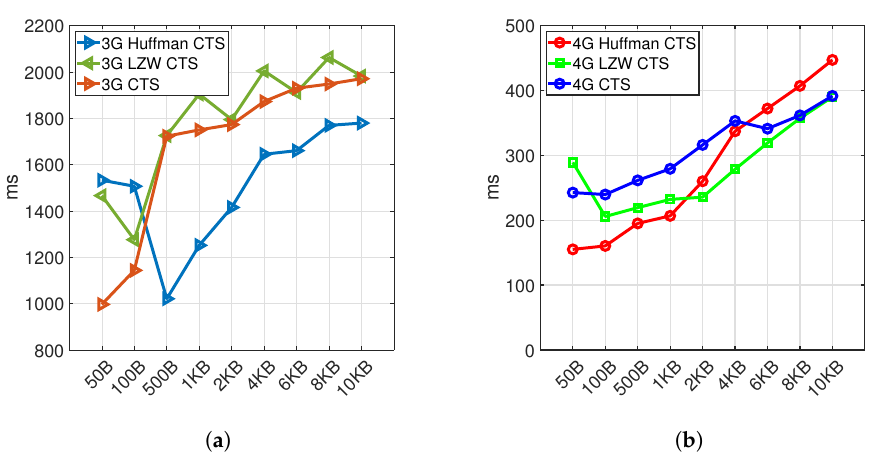
Figure 8. 3G ( a ) and 4G ( b ) median latency without and with Huffman and LZW compression techniques (CTS stand for Client-to-Server (Uplink)).